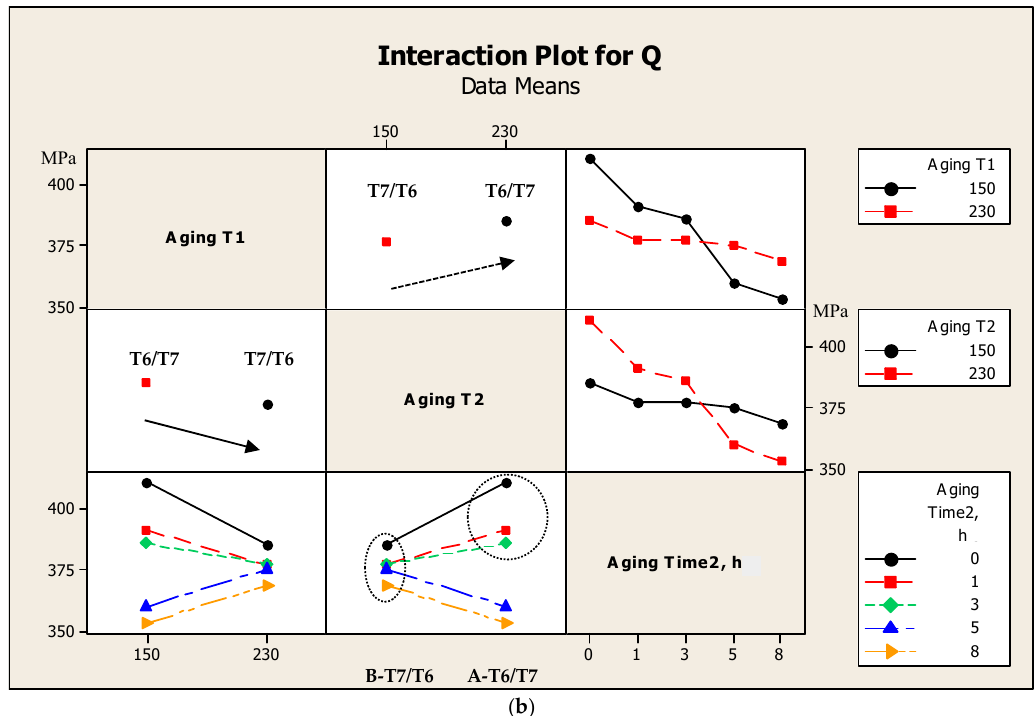
Figure 6. Interaction plot, using DOE, for the effect of ( a ) quenching media and heat treatment cycles and ( b ) aging parameters on the quality index, Q (MPa), values of A357-SSM heat-treated using multiple thermal aging treatments.